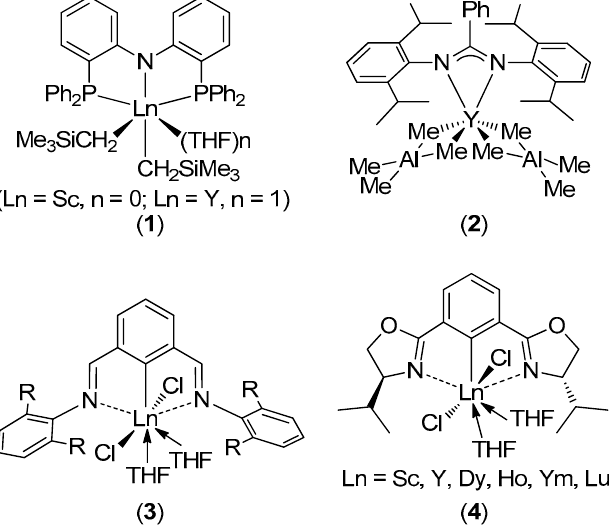
Chart 1. Representative examples of non-metallocene rare-earth metal complexes for cis -1,4-